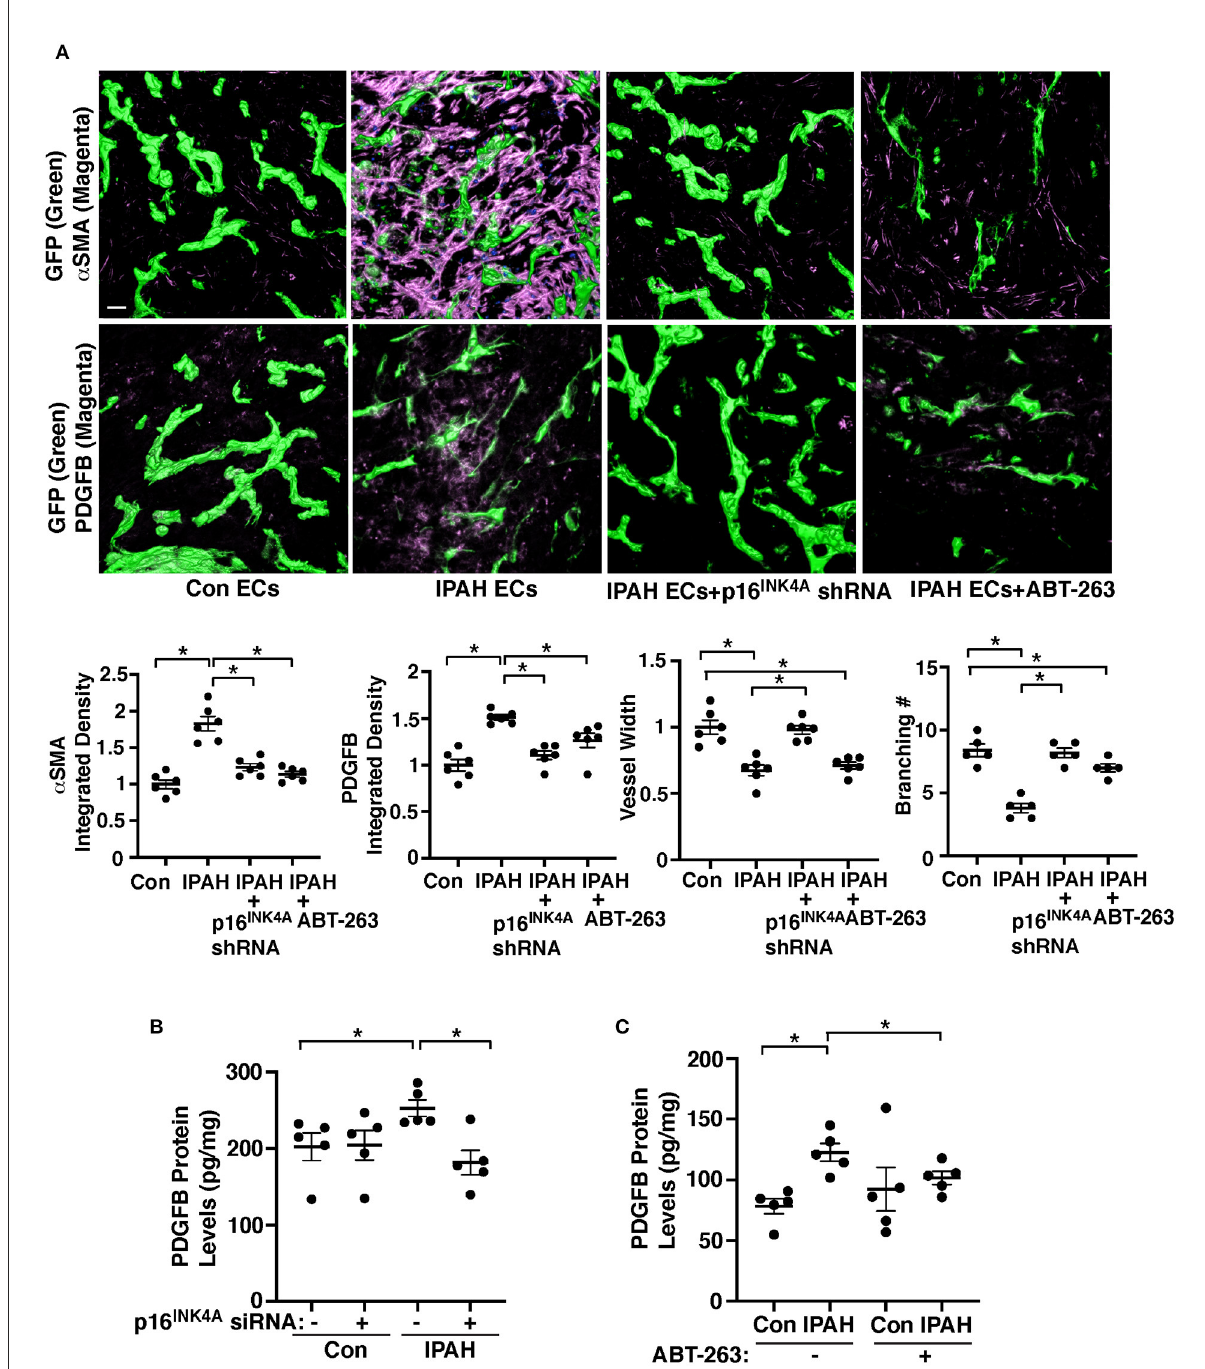
FIGURE4 Inhibition of EC senescence suppresses accumulation of α SMA-positive cells and PDGFB expression in the gel implanted on the mouse lung. (A) IF micrographs of fibrin gel supplemented with GFP-labeled healthy or IPAH patient ECs or in combination with treatment with p16 INK4 shRNA or ABT-263 and implanted on the NSG mouse lungs for 7 days; GFP-labeled blood vessels and α SMA expression ( top ) and GFP-labeled blood vessels and PDGFB expression ( bottom ) in the fibrin gel. Scale bar, 50 µ m. Graphs showing integrated fluorescent density of α SMA ( left ) and PDGFB ( 2nd , n = 6, mean ± SEM, * p < 0.05), vessel width ( 3rd , n = 6, mean ± SEM, * p < 0.05), and branching number ( right , n = 5, mean ± SEM, * p < 0.05). (B) Graph showing the protein levels of PDGFB measured by ELISA in healthy or IPAH patient PAECs or in combination with treatment with p16 INK4 siRNA or scrambled control siRNA ( n = 5, mean ± SEM, * p < 0.05). (C) Graph showing the protein levels of PDGFB measured by ELISA in healthy or IPAH patient PAECs or in combination with treatment with ABT-263 (250nM, n = 5, mean ± SEM, * p <